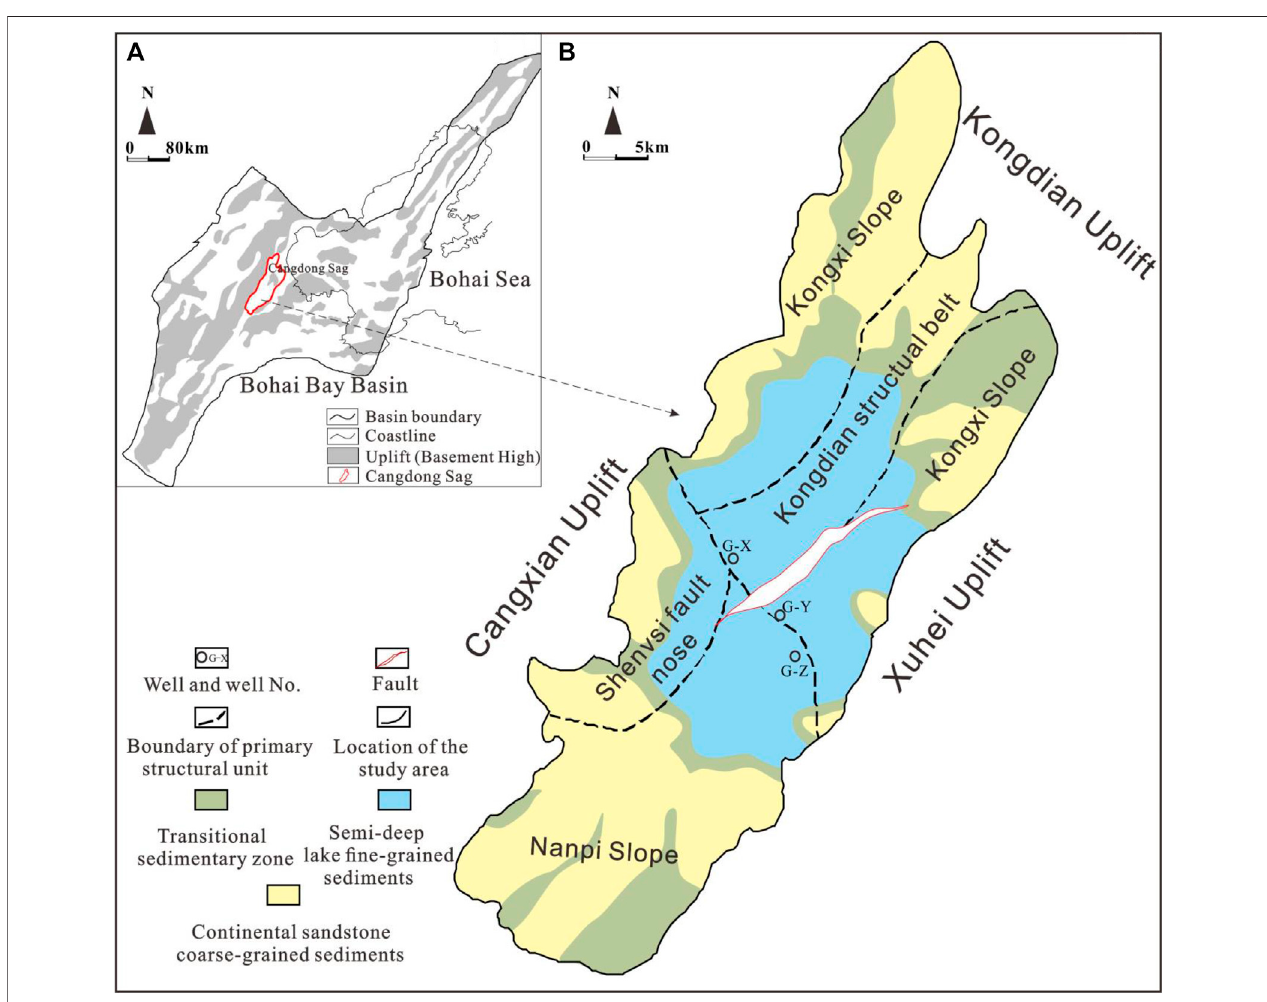
FIGURE1|(A) SketchmapshowingdepressionsoftheBohaiBayBasin(modi fi edafterHaoetal.,2007). (B) Simpli fi edstructuralmapoftheregionalsettingofthe Cangdong Sag (modi fi ed after Zhao et al., 2018; Zhou et al., 2020).